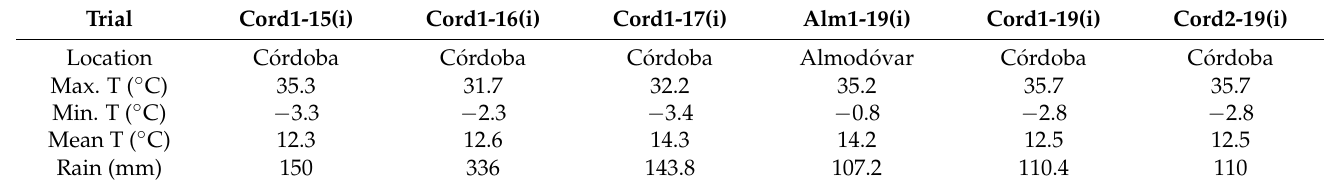
Table 1. Field trials carried out for the study of the effect of intercropping on the pathosystem pea/powdery mildew.